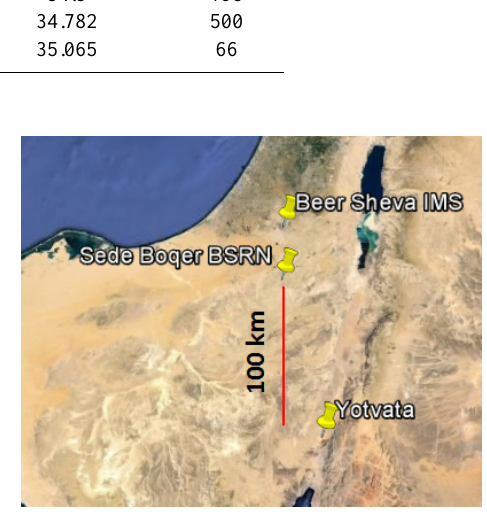
Figure 1. Map of the three stations. The red line is 100km in